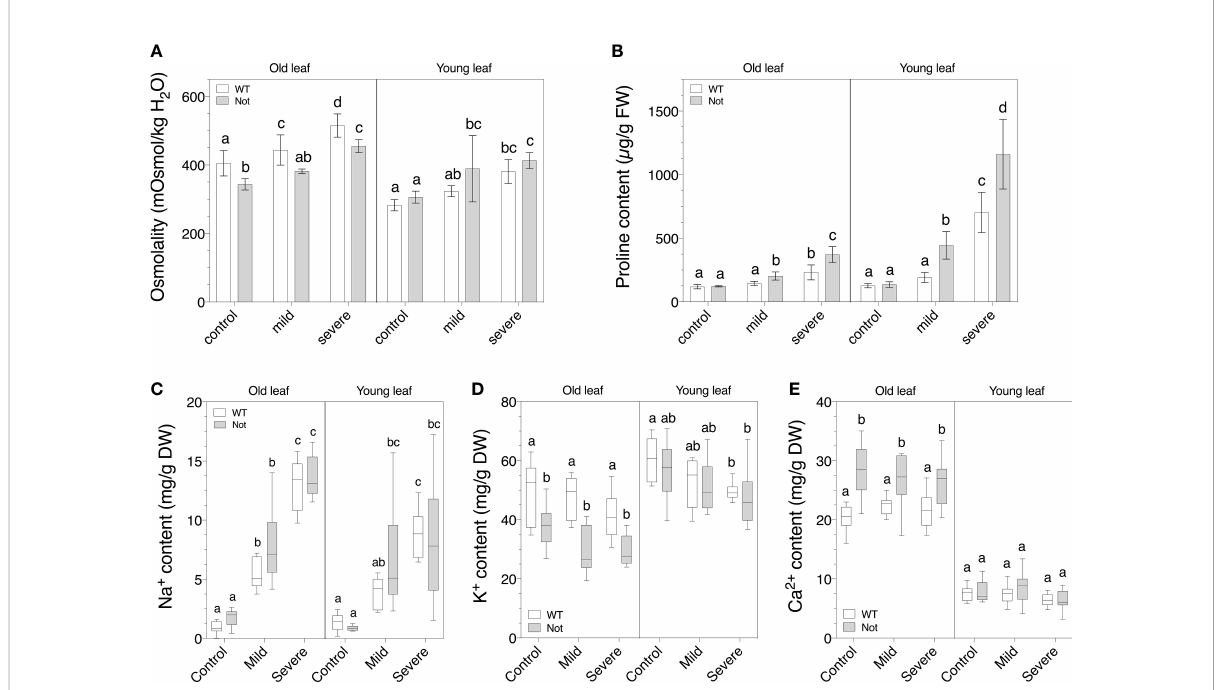
FIGURE 5 Osmotic balance of old (leaf no. 3) and young (leaf no. 8) leaves in wild-type (white) and notabilis (gray) after 7 days under control (EC of 2.5 dS/ m), mild (EC of 5 dS/m; [NaCl] = 47 mM) and severe (EC of 10 dS/m; [NaCl] = 94 mM) salt stress conditions. (A) Leaf osmolality as a measurement for total osmolyte content (n = 10), (B) leaf proline content (n = 10), (C) leaf sodium content (n = 10), (D) leaf potassium content (n = 10) and (E) leaf calcium content (n = 10). Signi fi cant differences are indicated with different letters ( a =